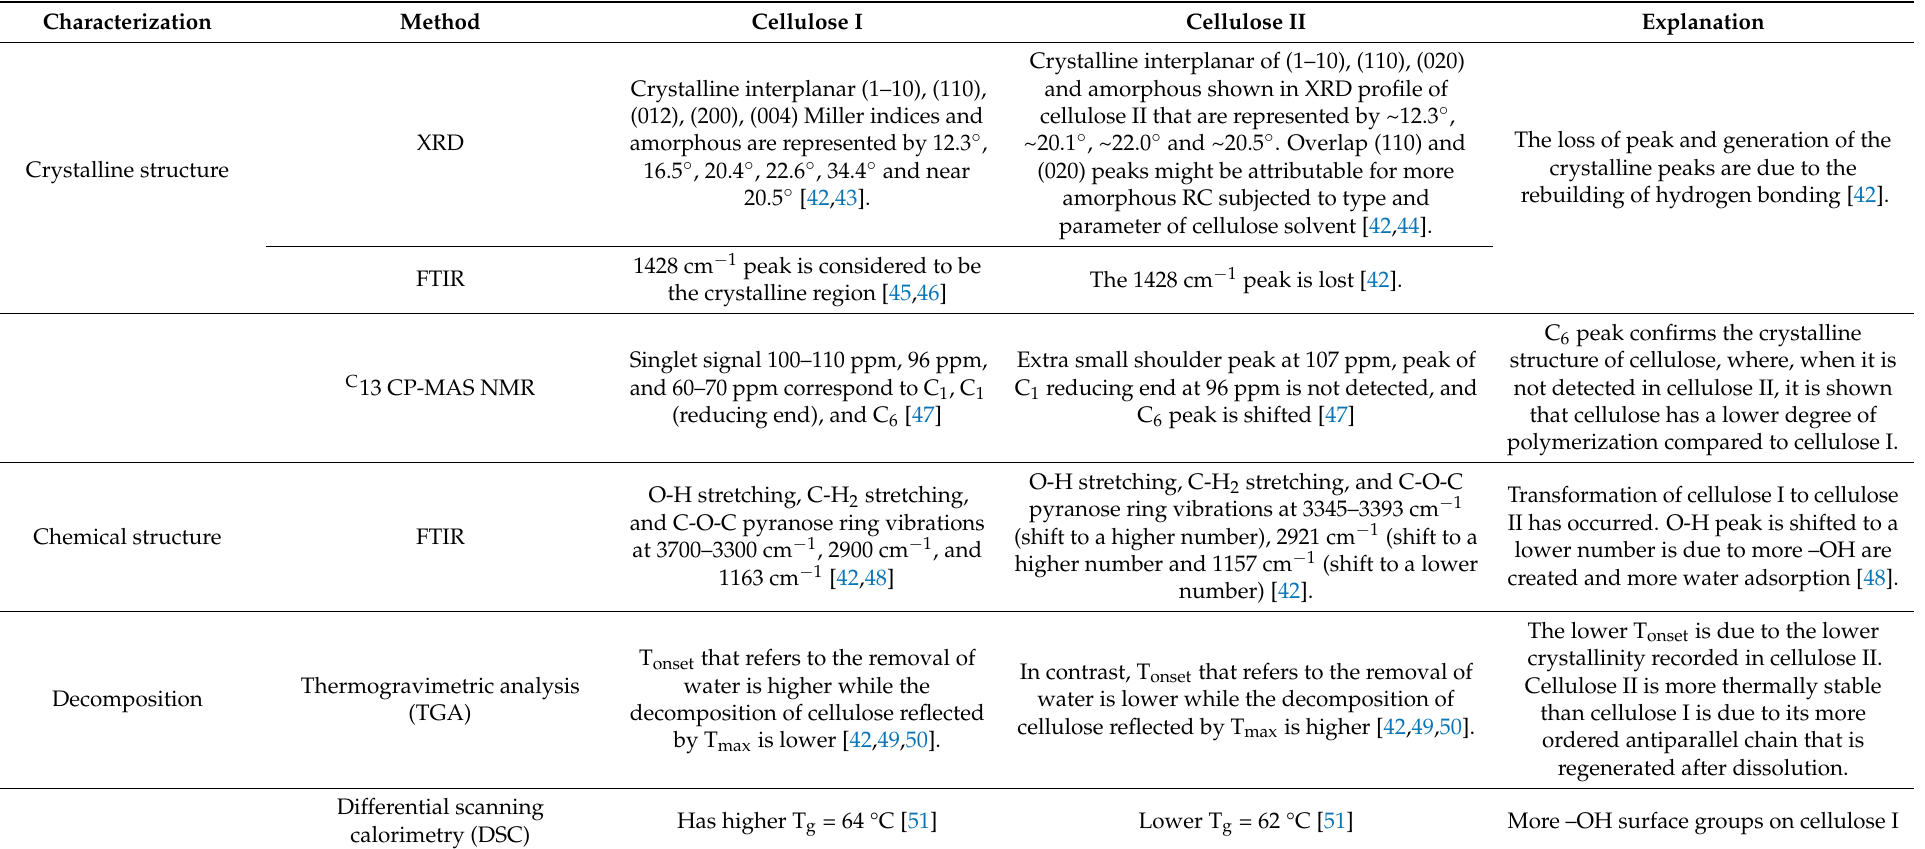
Table 2. The characterization of transformation of cellulose I to cellulose II via XRD, Fourier-transform infrared spectroscopy (FTIR), 13 C NMR, and Raman